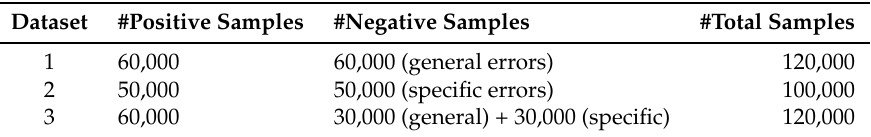
Table 6. Statistics of Corpuses.